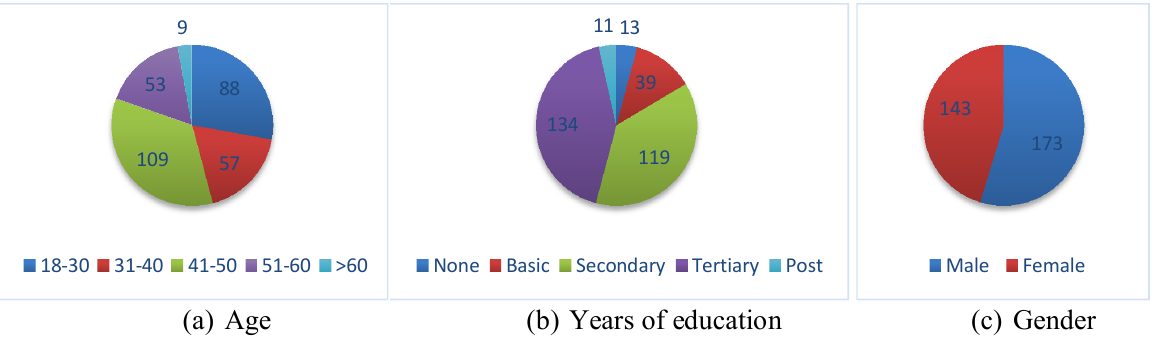
Fig. 1. Personal characteristics of the